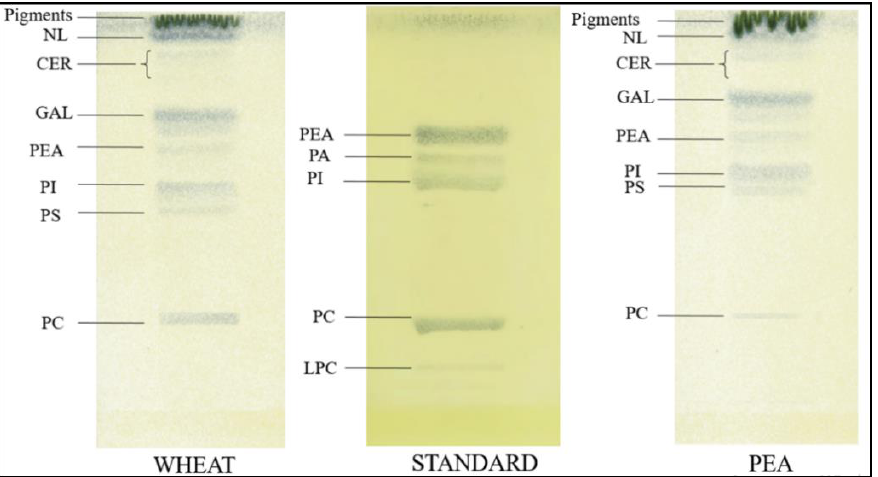
Figure 6. Typical thin layer chromatography (TLC) patterns from extracts of wheat and pea leaves.